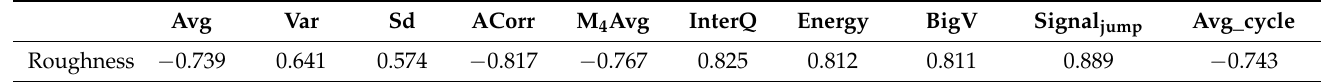
Table 7. Pearson correlation coefficient